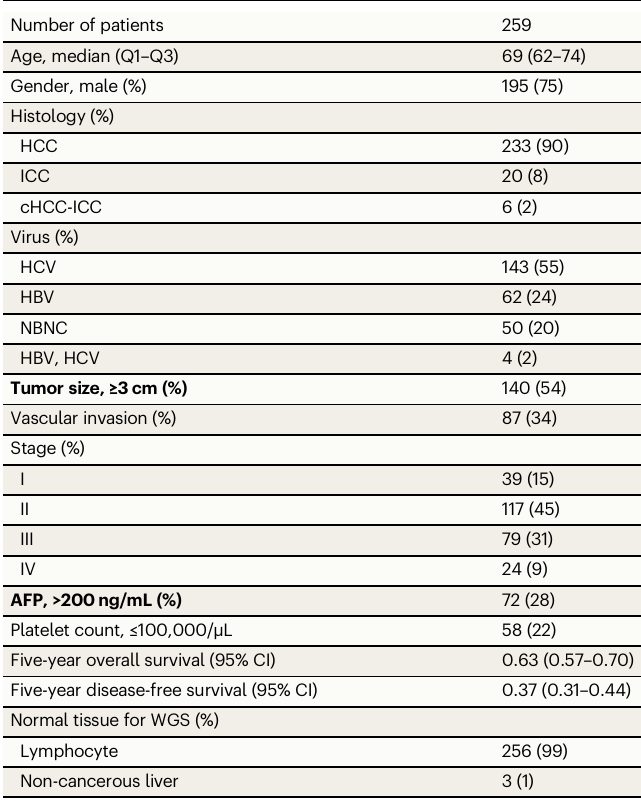
Table 1 | Clinical information of liver cancer patients Number of